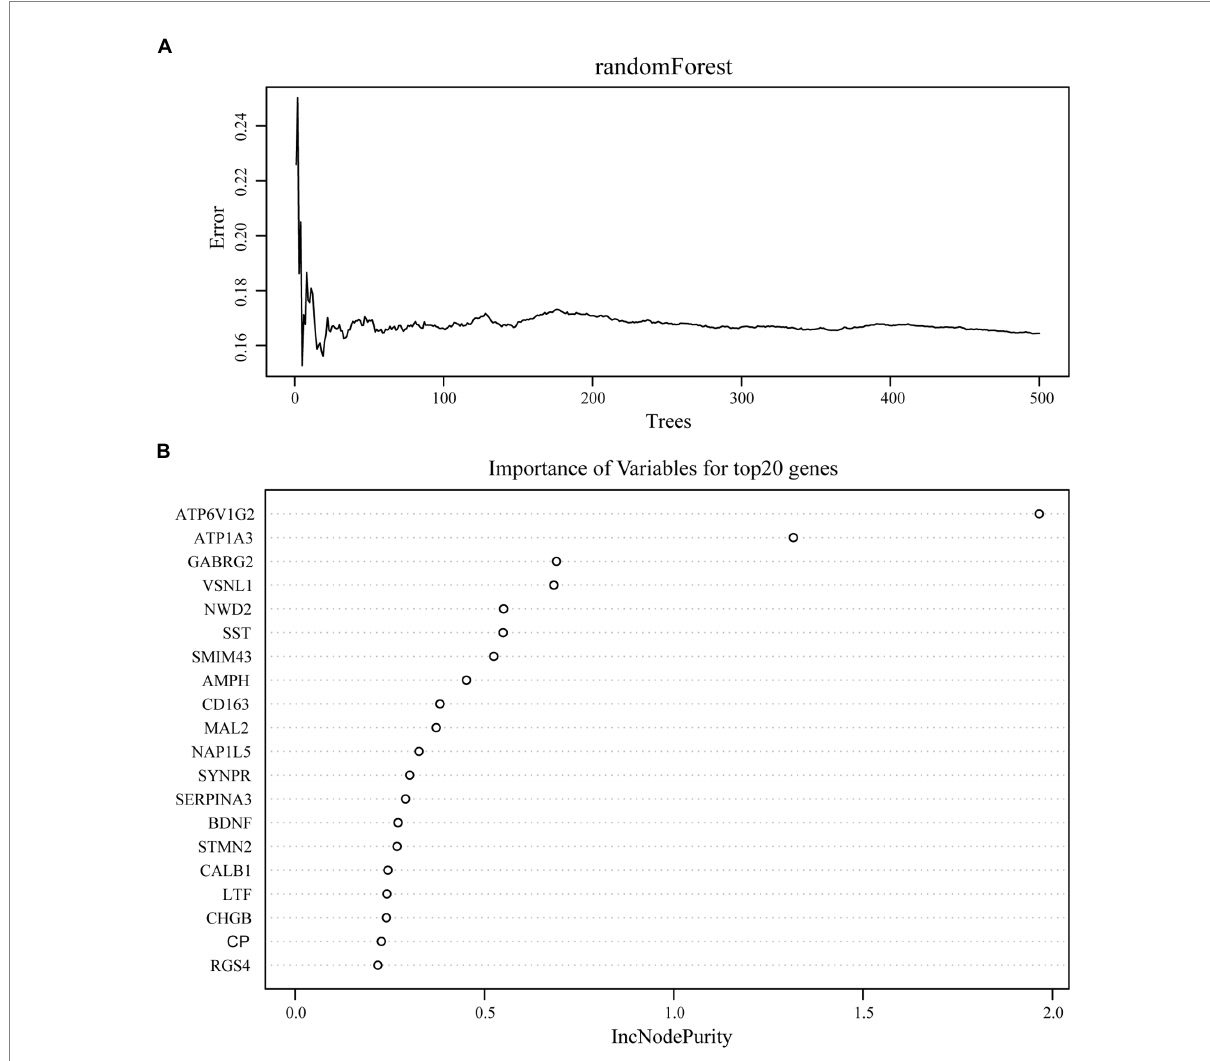
FIGURE 8 Screening of diagnostic candidates by machine-learning approach. (A) The randomForest algorithm is used to construct a prediction model. (B) Importance of variables for top20 genes recognized from random forest